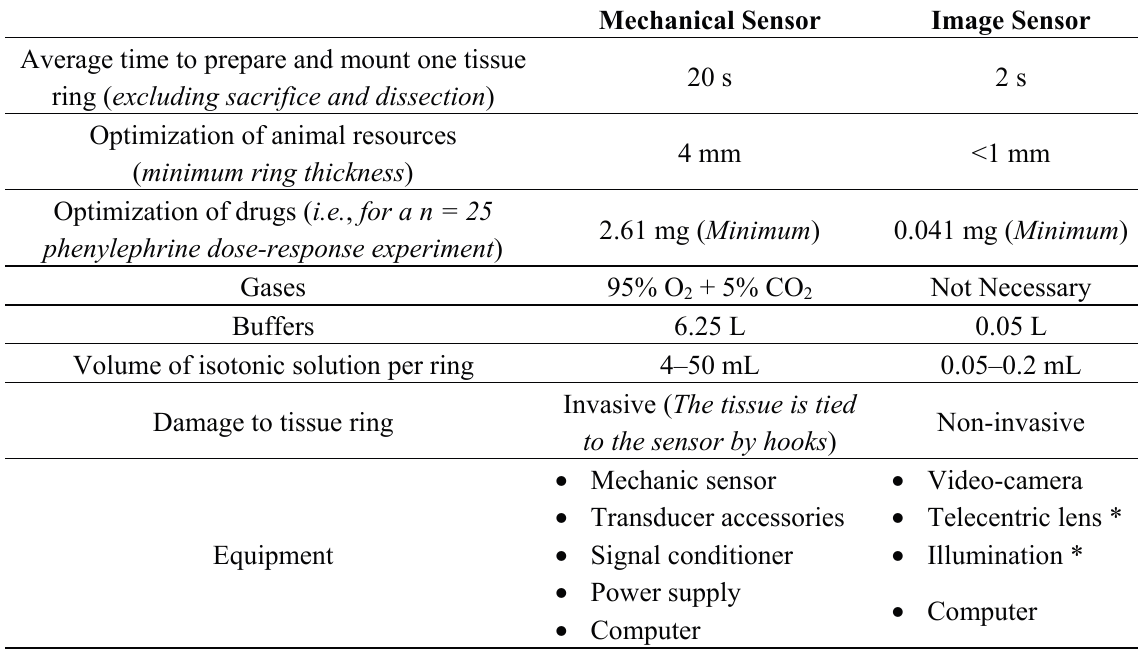
Table 1. Advantages over the classical